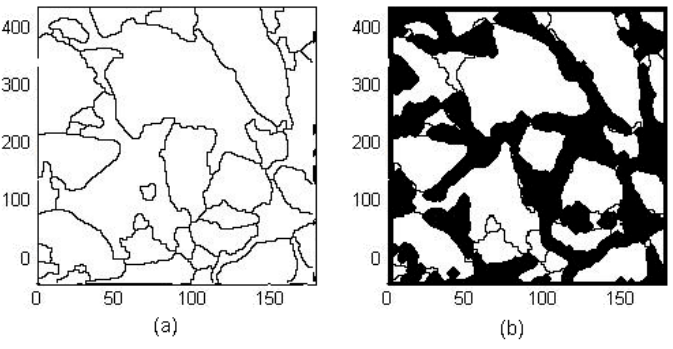
Figure 10. ( a ) Watershed result; ( b ) subtraction result.